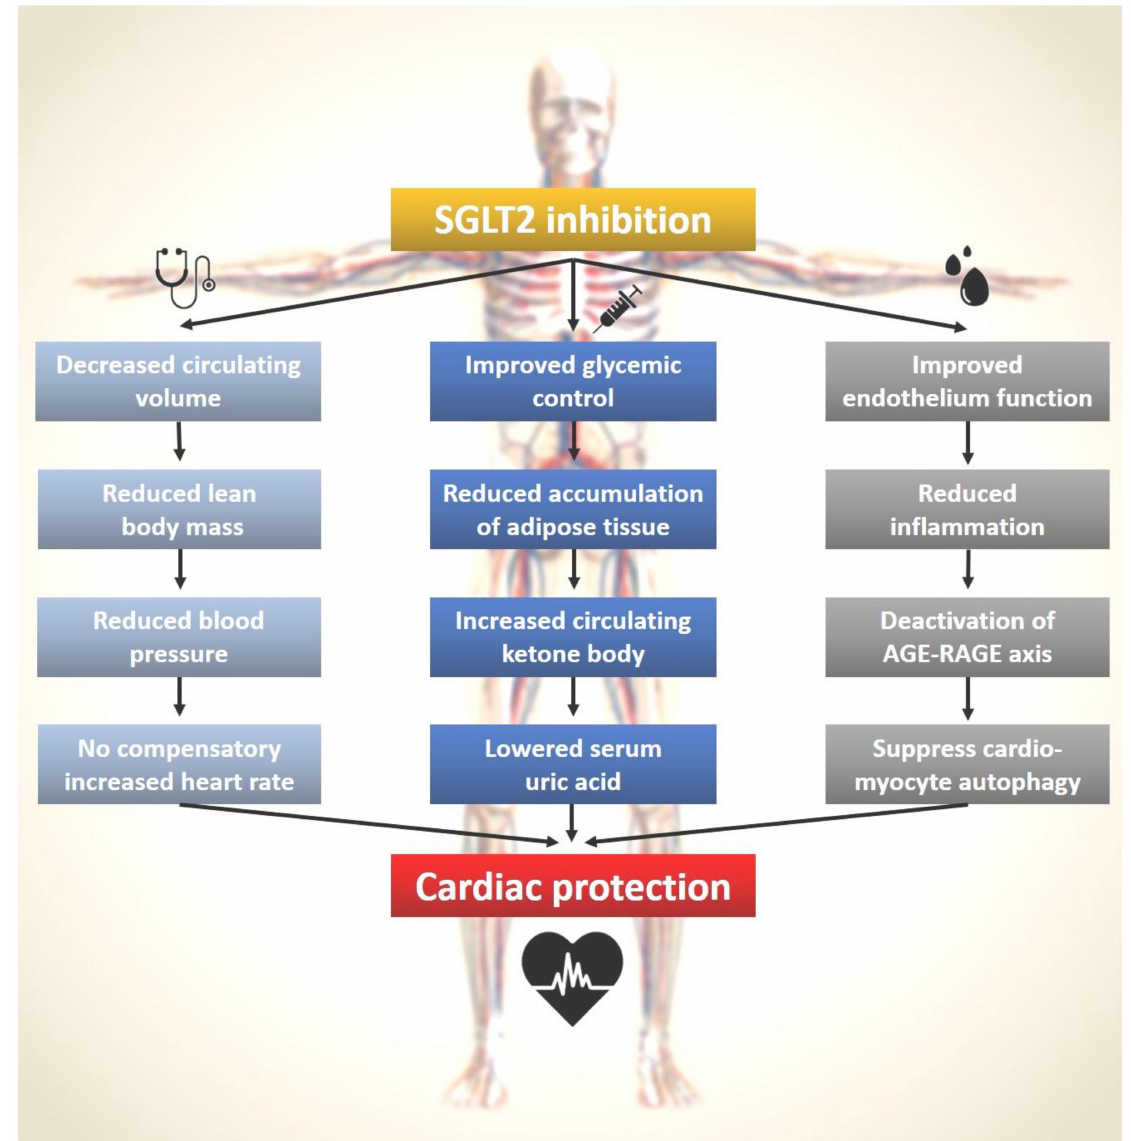
Figure 2. SGLT2 inhibitors and the pleiotropic effects on cardiac protection. The left panel with the stethoscope symbol shows the macroscopic actions of SGLT2 inhibitors that can be observe clinically. The middle panel with the syringe symbol illustrates the microscopic changes by SGLT2 inhibitors that can be checked via a blood test. The right panel with the symbol of a drop of blood outlines the molecular mechanisms of SGLT2 inhibitors that can be studied in basic science